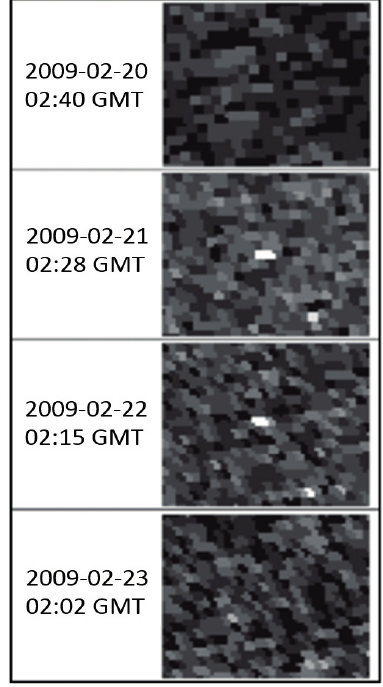
Figure 4. Example series of DMSP OLS images at Karval Wildlife Area during field collection. These images over four consecutive days which include before, during, and after. Field work (lights on) in the middle (21 February 2009 and 22 February